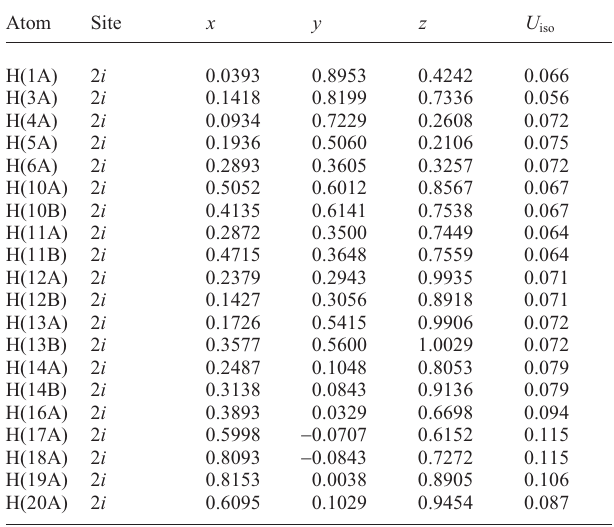
Table 2. Atomic coordinates and displacement parameters (in Å 2 )